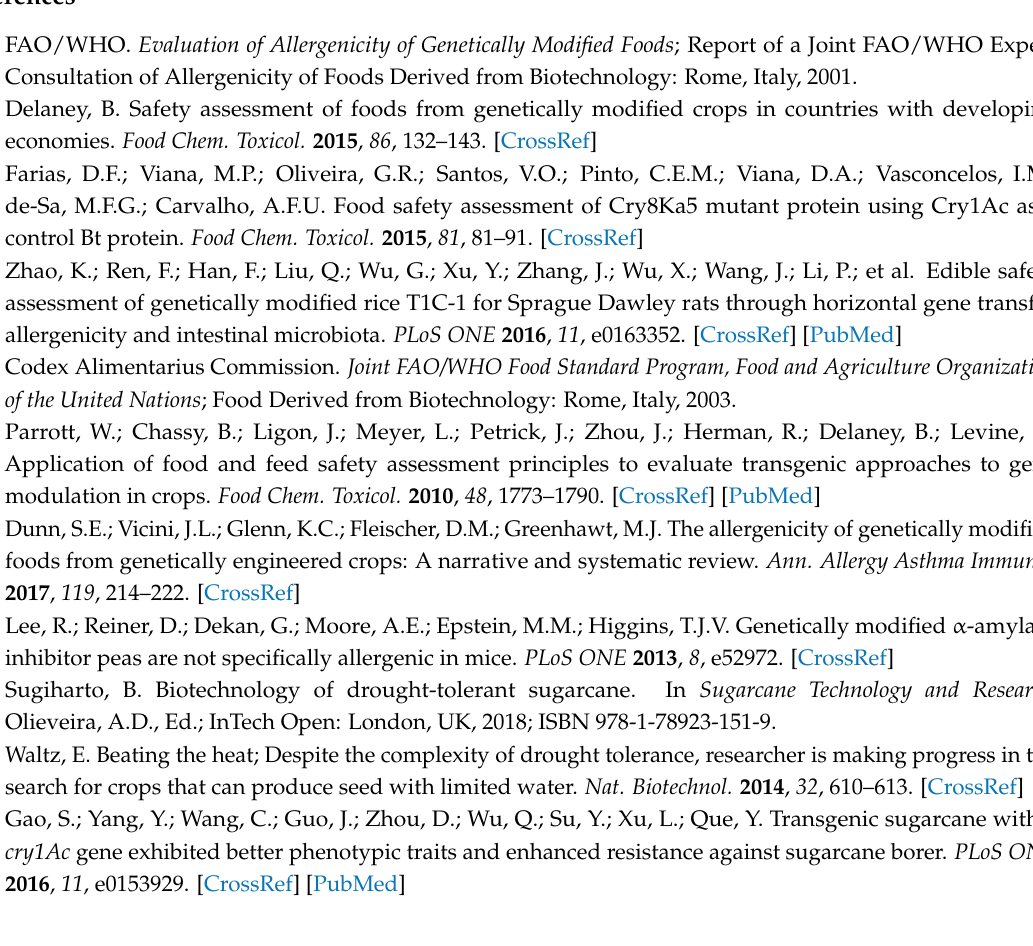
Figure S1: The corresponding amino acid sequences of So SPS1 (a). The result of a sliding 80 amino acids window for So SPS1 obtained through the database of Allergen Online, version 18B (b), Figure S2: The positive transgenic sugarcane (SP1, SP2, SP3, SP4) and non-transgenic sugarcane (WT1 and WT2) genes were detected by PCR